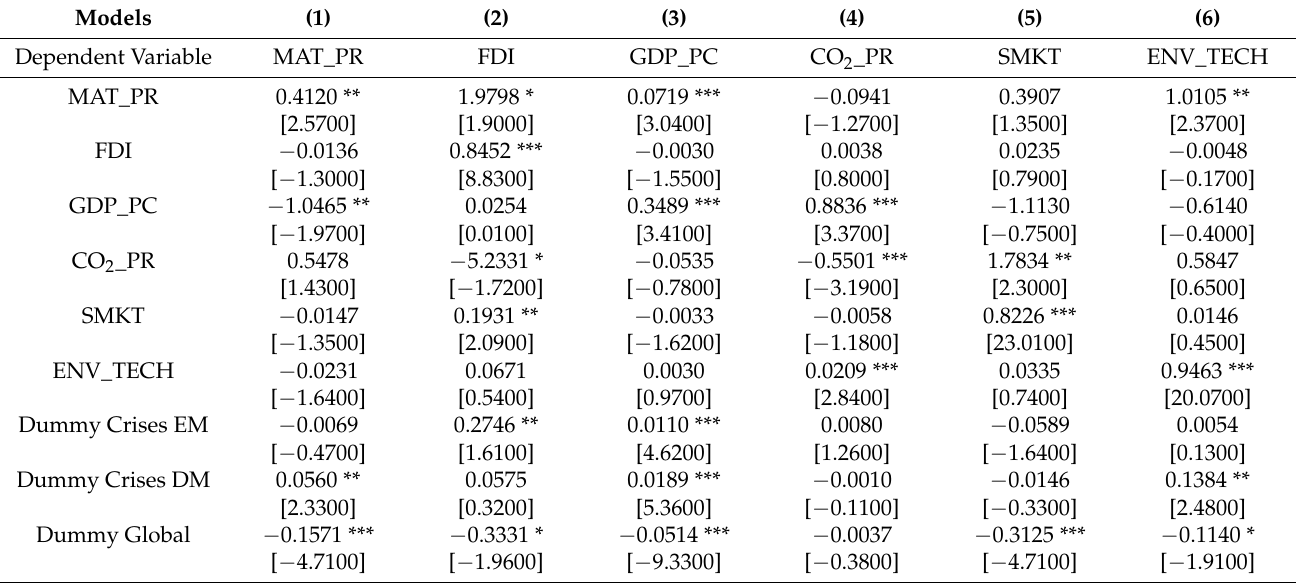
Table 2. The Global Group PVAR